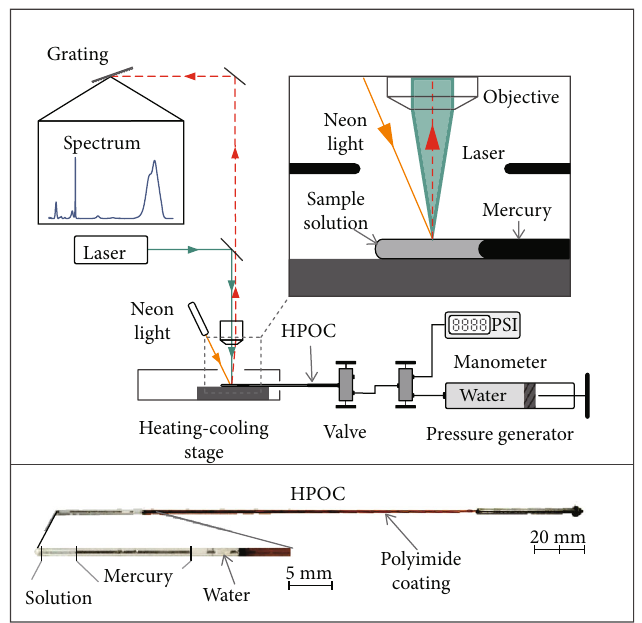
Figure 1: A schematic diagram showing the experimental setup. The lower part is a photo of a prepared HPOC containing sample solution, mercury, and pressure medium (water in this